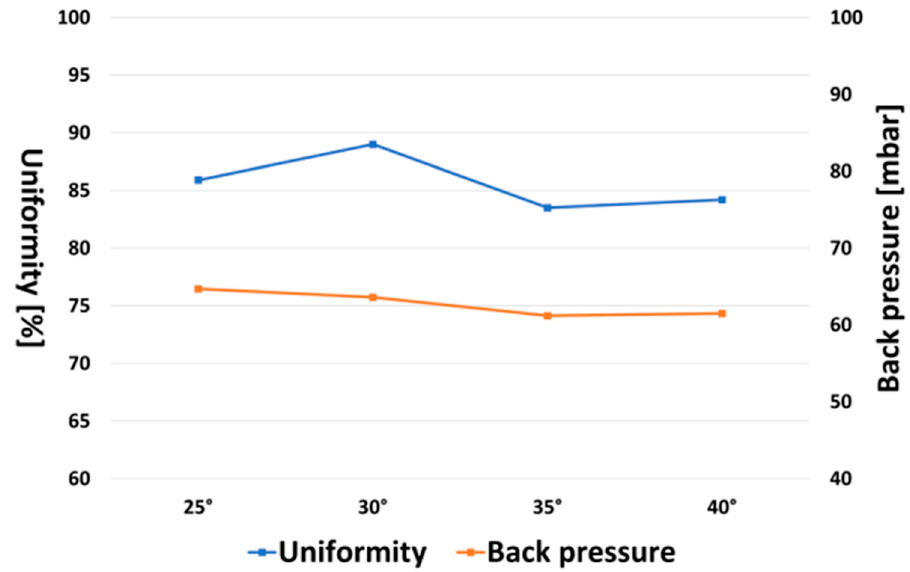
Figure 9. SCR diffuser angle type: ( a ) 25°, ( b ) 30°, ( c ) 35°, ( d ) 40°.